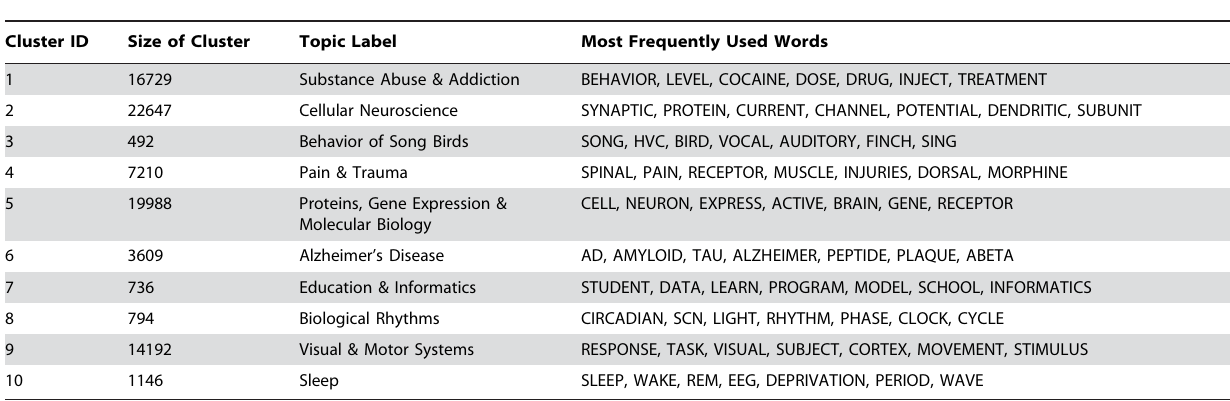
Table 6. The 10 clusters produced by the NCuts algorithm performed on the nearest-neighbor graph from year 2001–2006 (see Materials and